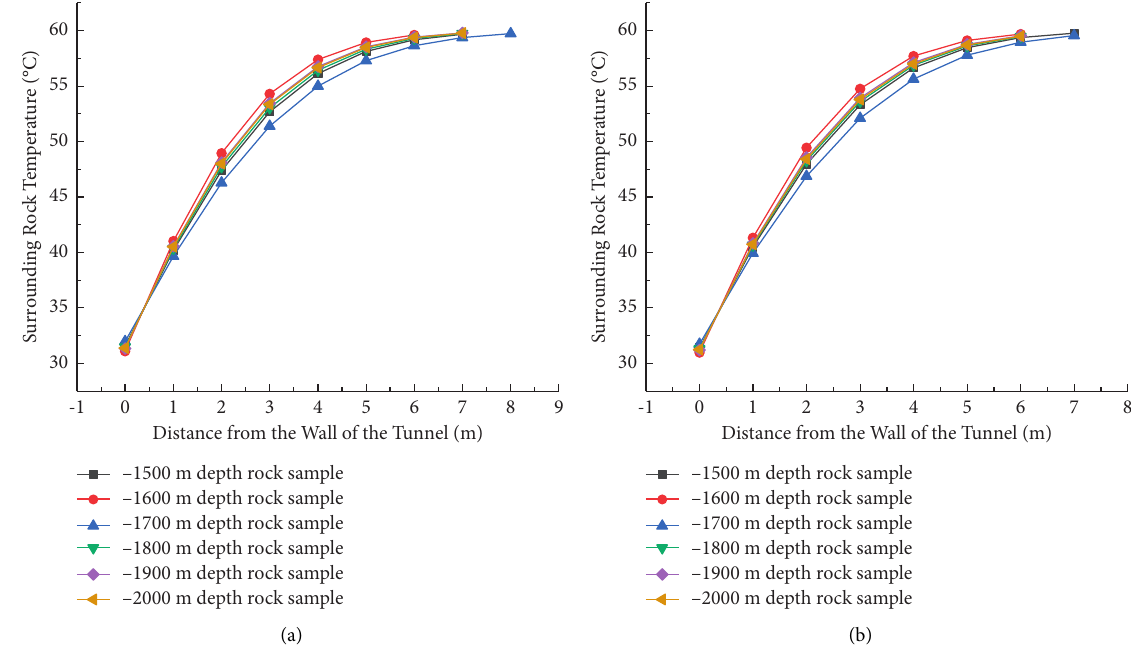
Figure 5: Temperature distribution in the heat-regulating circle of surrounding rocks of rock samples of different depths. (a) Room- temperature thermophysical parameters. (b) High-temperature thermophysical